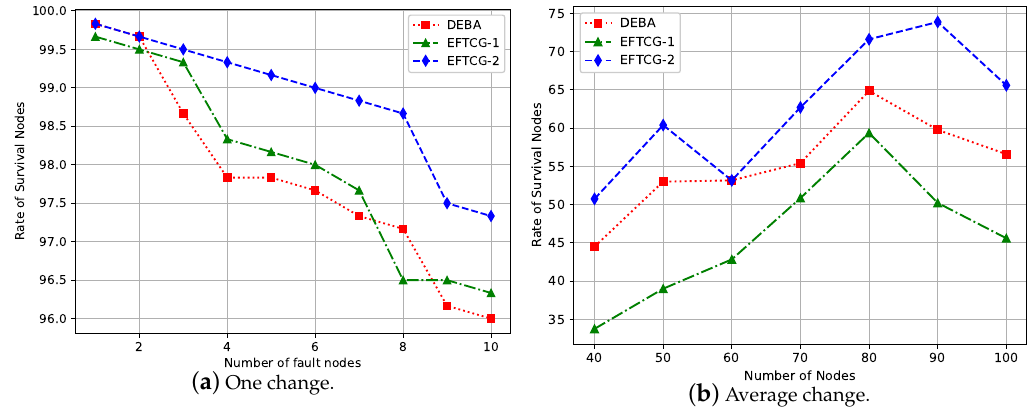
Figure 12. The rate of connectable node pairs, ( a ) the change of the rate of connectable node pairs with the generation of failure nodes when the number of nodes is 100; ( b ) the change of the rate of connectable node pairs under different node density after 10 failure nodes